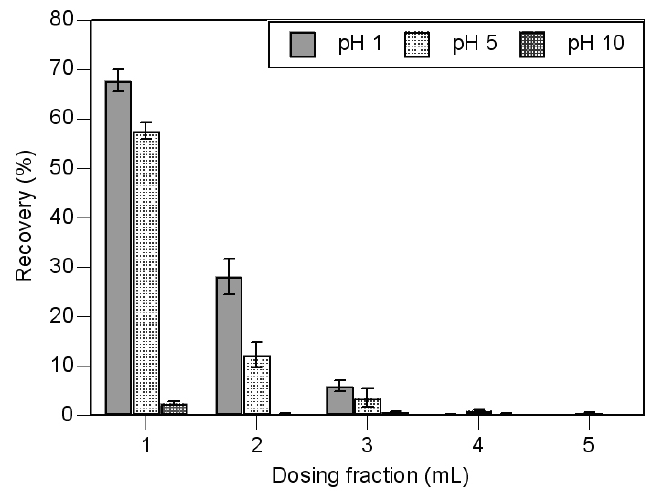
Figure 2. Effect of pH on the performance of MRT-SPE material. Sample solution: 0.03 mg L –1 Pb(II), volume: 10 mL (2 mL per dosing fraction), loading flow rate: 1 mL min –1 , eluent: 4 M KCl, eluent volume: 1.5 mL, elution flow rate: 1 mL min –1 ( n =